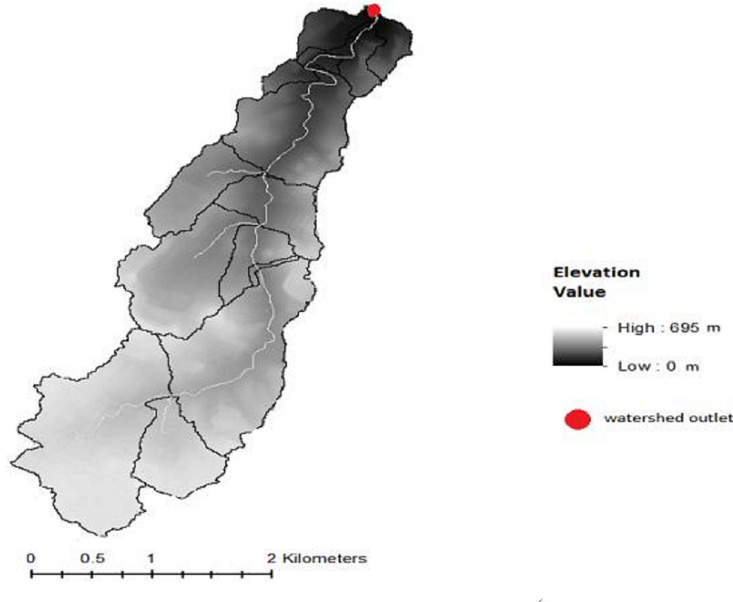
Fig. 1 Blunn Creek